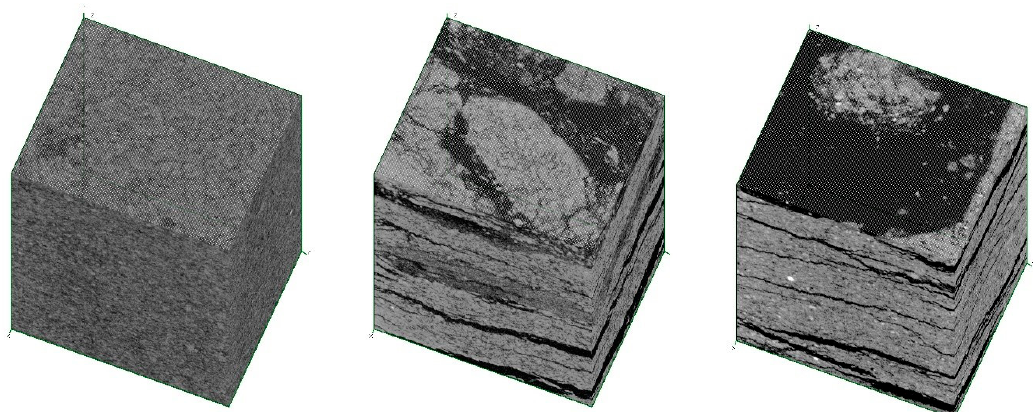
Figure 7. Examples of virtually-cut, three-dimensional projections of 4 × 4 × 4 mm 3 cubes from specimens “D” ( left ), “D T ” ( center ) and “B T ” ( right ). Specimen “D” shows the regular microstructure without faults such as delaminations. The results of the elevated temperature impact is visible within the volume of specimen “D T ” and “B T ” in the form of significant delaminations.